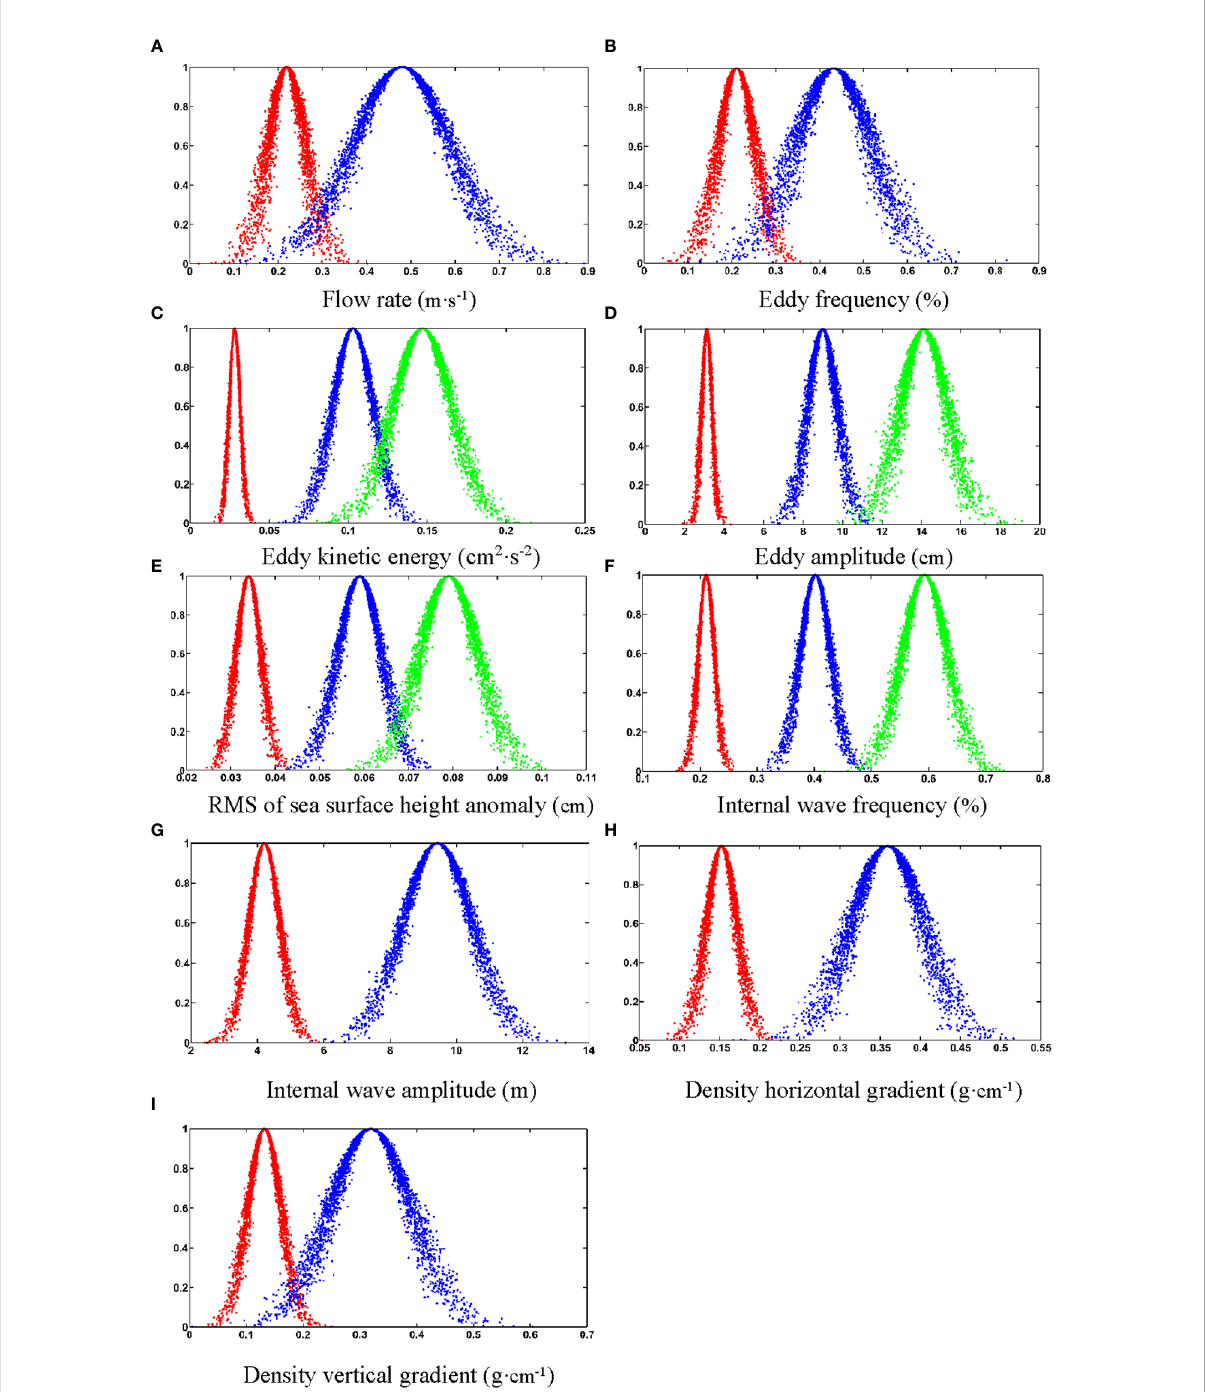
FIGURE 2 The cloud expression of indicator level. [Flow rate (A) ; Eddy frequency (B) ; Eddy kinetic energy (C) ; Eddy amplitude (D) ; RMS of SSHa (E) ; Internal wave frequency (F) ; Internal wave amplitude (G) ; Density horizontal gradient (H) ; Density vertical gradient (I)